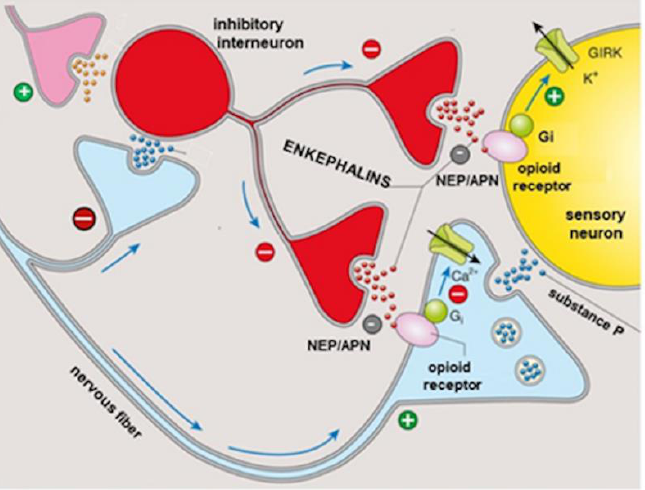
Figure 2. Enkephalin signaling in the pain pathway. Enkephalins are released by inhibitory interneurons activated as a result of the balance between positive (anti-nociceptive) and negative (pain) inputs. Enkephalins are able to activate opioid receptors evoking analgesic signaling; their efficacy is limited by the catabolic enzymes NEP and APN. GIRK = G protein-coupled inwardly rectifying potassium, NEP = neutral endopeptidase, APN = Aminopeptidase N, Gi = Gi protein. Modified from an image available on: www.slideplayer.it. (Accessed on 23 July 2021).